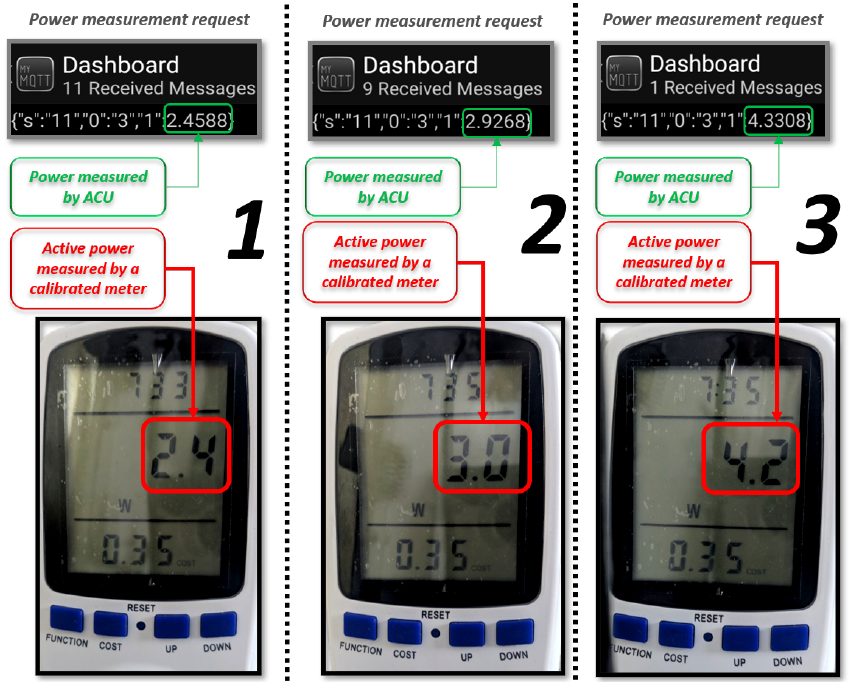
Figure 17. Active power values predicted by the ACU-LUM and measured by a calibrated meter.